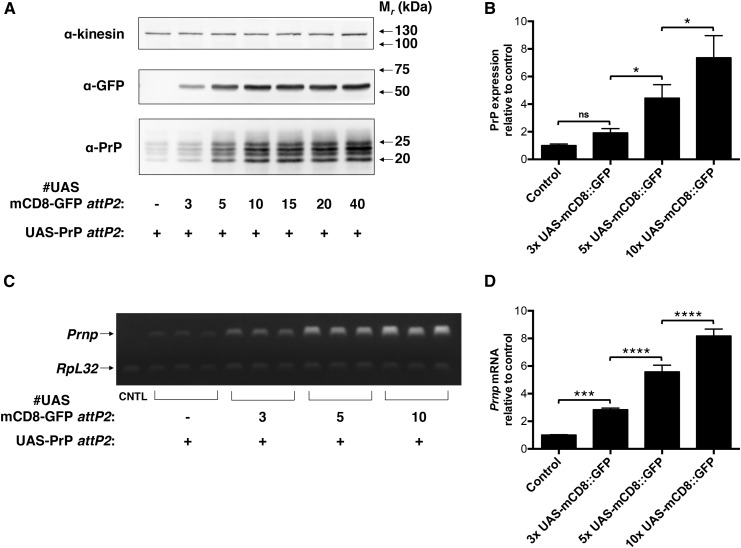
Increasing UAS enhancer strength at the attP2 locus in trans increases attP2 UAS-PrP expression. UAS-mCD8::GFP constructs with variable UAS number were expressed at attP2 in trans to UAS-PrP, with expression driven by Cha-GAL4. (A) Western blot of fly head homogenates. Experiment was performed in triplicate with a representative blot shown. (B) Densitometry of Western blot signals in (A) and associated replicates. PrP signals were normalized to the kinesin loading control and then to the hemizygous attP2 UAS-PrP line lacking UAS-mCD8::GFP in trans. (C) Semiquantitative RT-PCR performed on fly head mRNA. Prnp and RpL32 transcripts were coamplified in the same PCR reactions, and each lane represents a biological replicate. CNTL is of mRNA prepared from UAS-PrP flies that do not express GAL4. (D) Densitometry of RT-PCR signals in (C). For each sample, the ratio of Prnp to RpL32 mRNA levels was taken and then normalized to the average value for the attP2 UAS-PrP line lacking UAS-mCD8::GFP in trans. Error bars in (B) and (D) represent standard deviations, with n = 3 for each group; ns denotes not significant, * P < 0.05, *** P < 0.001, and **** P < 0.0001. Control sample, CNTL; GFP, green fluorescent protein; mRNA, messenger RNA; PrP, prion protein; RT-PCR, reverse transcription polymerase chain reaction.